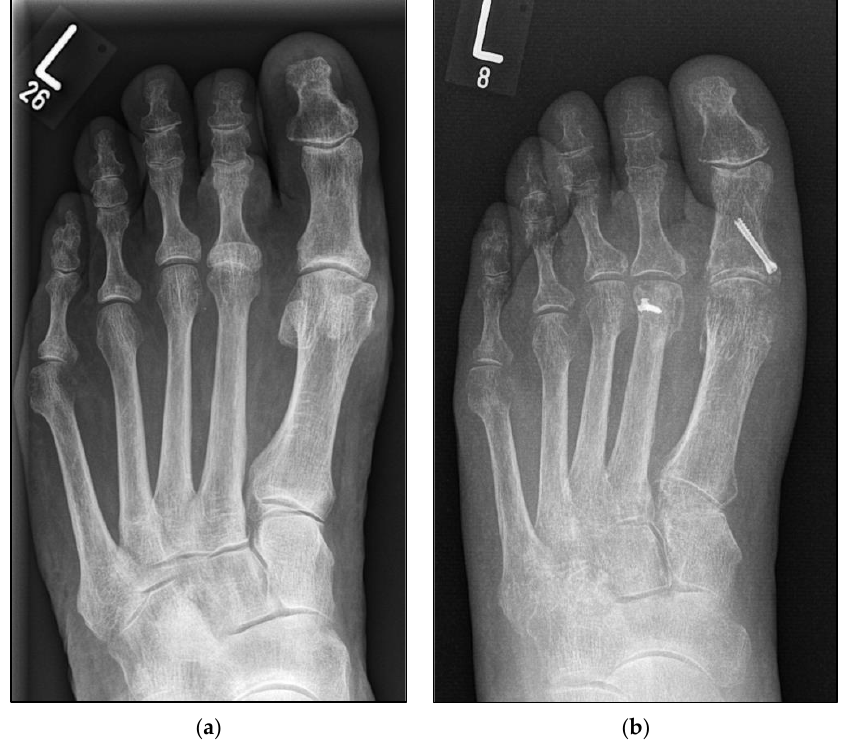
Figure 1. Pre- and postoperative radiographic findings of combined Weil osteotomy (group A with screw) and hallux valgus surgery, left foot. ( a ) Anteroposterior view preoperative, ( b ) anteroposterior view 3 months postoperative.